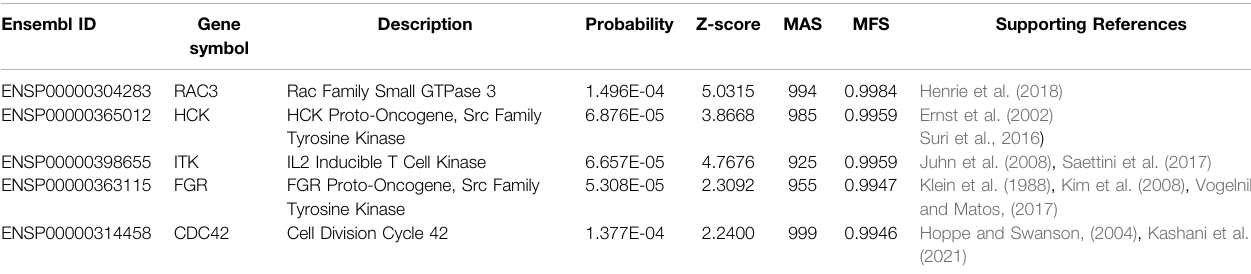
TABLE 3 | Five putative otitis media